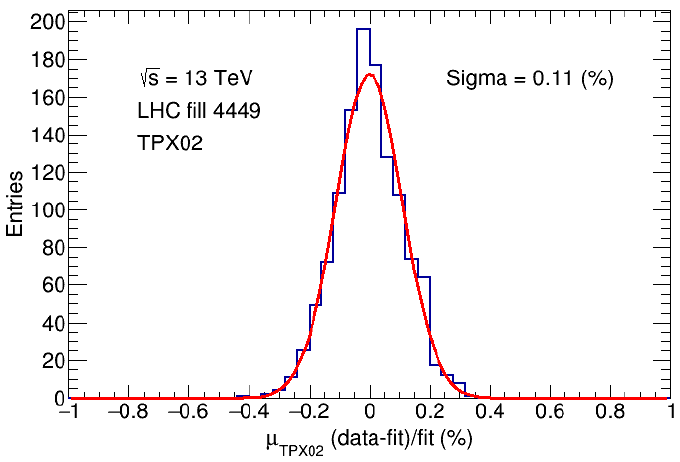
Figure 39. Gaussian fit of the relative difference between the data and the fitted average number of interactions per bunch crossing as a function of time, seen by TPX02 averaged over layers 1 and 2. The data are shown for 10 frames (1s each) combined in order to decrease the statistical uncertainty. LHC fill 4449. Taken from Ref.